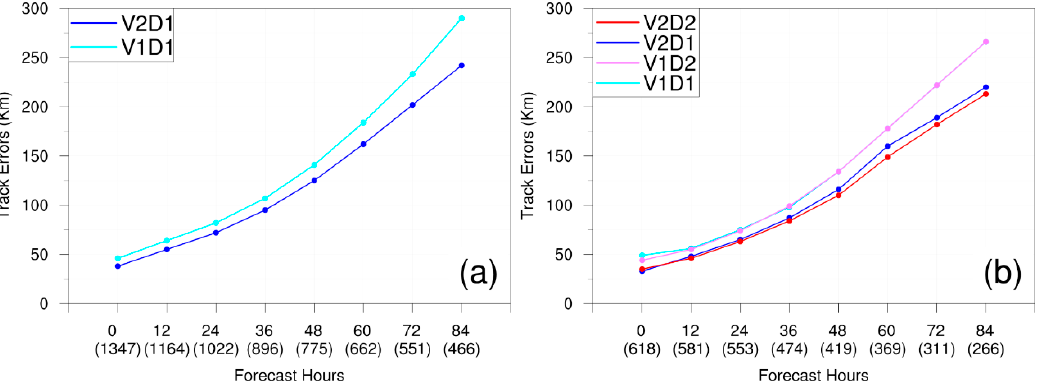
Figure 2. Homogeneous comparisons of track errors with TWRF at 0~84-h lead times ( a ) V1D1 and V2D1 ( b ) V1D1, V1D2, V2D1 and V2D2 domains from 2016 to 2018. The numbers in parentheses along